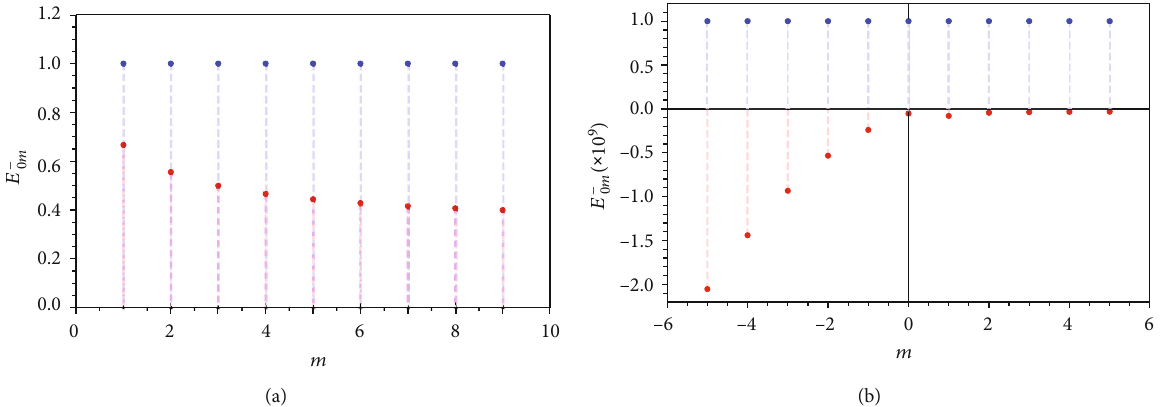
Figure 4: Illustration of the energy eigenvalues in the pseudospin symmetry limit (equation (56)) as a function of the parameter m for (a) s = 1 and (b) s = − 1 . We use units such as M = 1 , n = 1 , b = 1 , and ε = 10 − 7